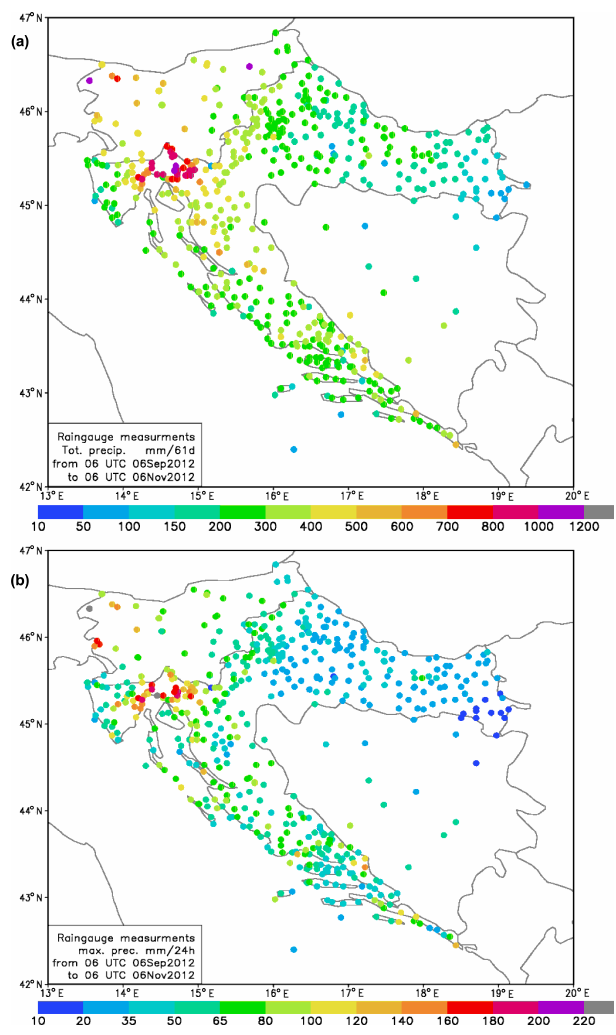
Figure 2. (a) Total precipitation measured by the Croatian rain gauge network, cumulated over the entire SOP1 period. (b) Max- imum 24h rainfall totals at each rain gauge station during